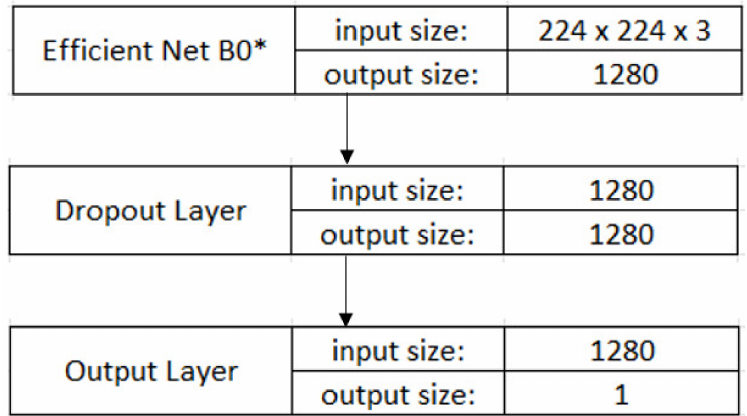
Figure 6. Model architecture (EfficientNet without its last layer). The “*” refers to the “(EfficientNet without its last layer)” in the figure